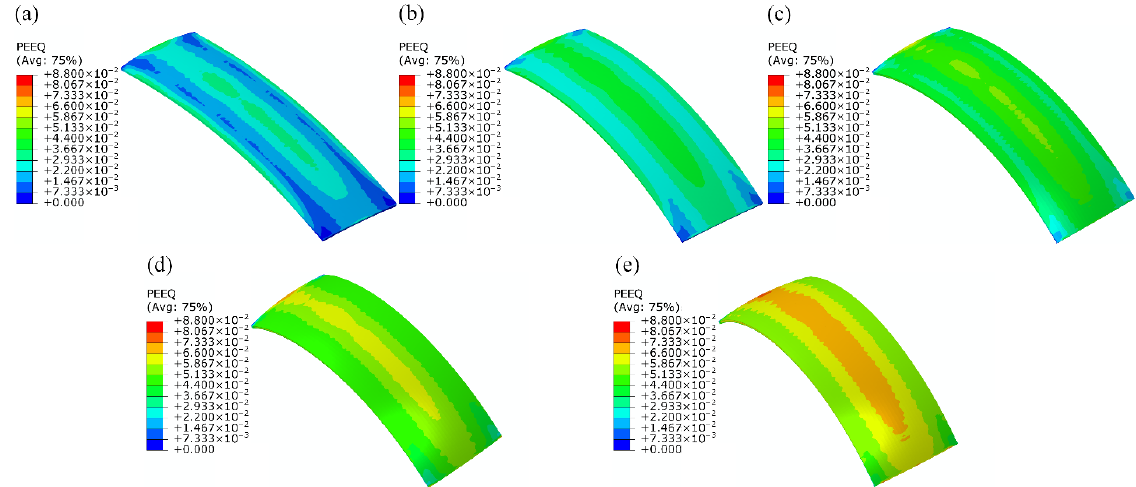
Figure 6. Equivalent plastic strain (PEEQ) distribution with different rolling reductions of the sheet metals: ( a ) ∆ h = 0.04 mm; ( b ) ∆ h = 0.06 mm; ( c ) ∆ h = 0.08 mm; ( d ) ∆ h = 0.10 mm; ( e ) ∆ h = 0.12 mm.